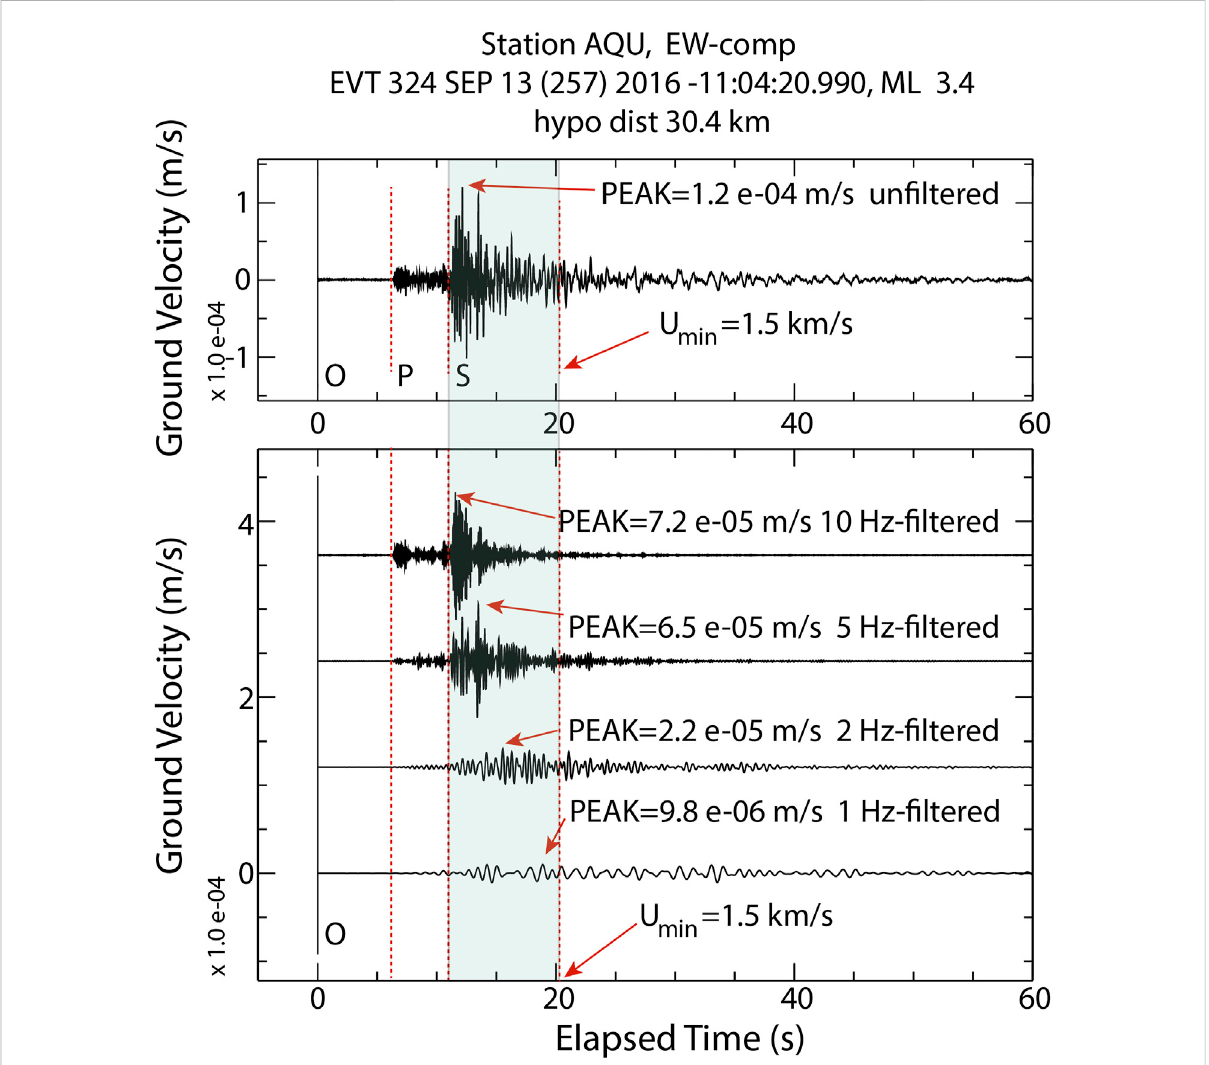
FIGURE 3 Filteringunderwentbyeachseismogramofthedataset,beforeharvestingpeakvaluesatasetofcentralfrequencies. Topframe :un fi lteredtime history. Bottom frame: narrowband- fi ltered versions of the seismogram at four central frequencies ( f c (cid:2) 1.0, 2.0, 5.0, and 10.0 Hz, bottom frame). Indicatedarethepeakvalues,andthepositionofeach fi lteredpeak.ValidpeakvaluesmustbelocatedaftertheS-wavearrival,andbeforeaminimum groupvelocity(wechose1.5 km/s).Theareashadowedingreenindicatesthetimewindowinwhichthepeakvaluesaresearched.Filtersusedin this Figure, as well as for the data analysis, are Butterworth 8-pole, causal fi lters; their corner frequencies around each f c are: ( 1/